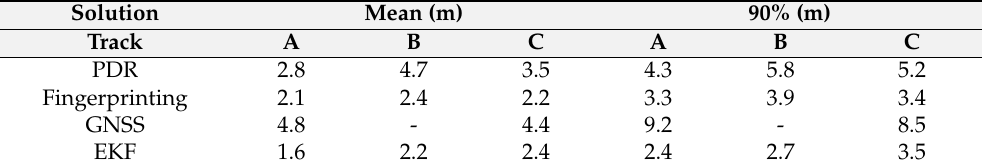
Table 4. Positioning accuracies of the PDR, fingerprinting, GNSS, and EKF